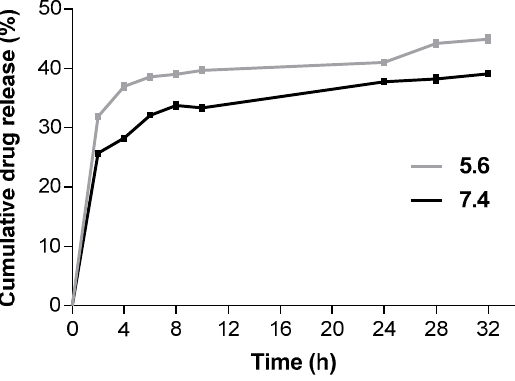
Figure 2. Cumulative drug release profile for L–QD–TPT at mild acidic (pH 5.6) and neutral conditions (pH 7.4). Data are presented as mean ± SD ( n = 3).